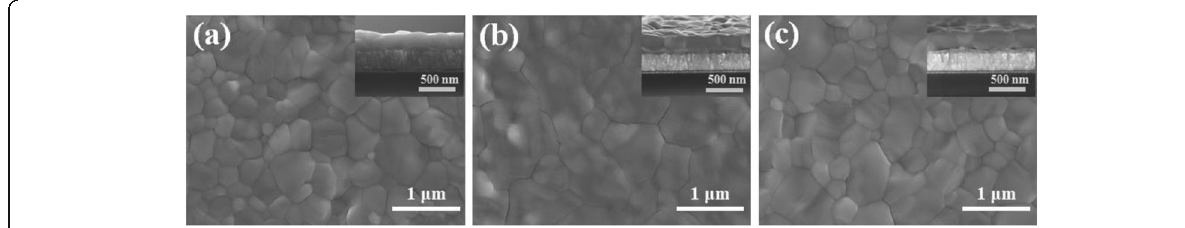
Fig. 2 The surface and cross-sectional morphologies of perovskite films: a MAPbI 3 , b MAPbI x Br 3 − x , and c G-MAPbI x Br 3 − x . The inserts are their cross-sectional